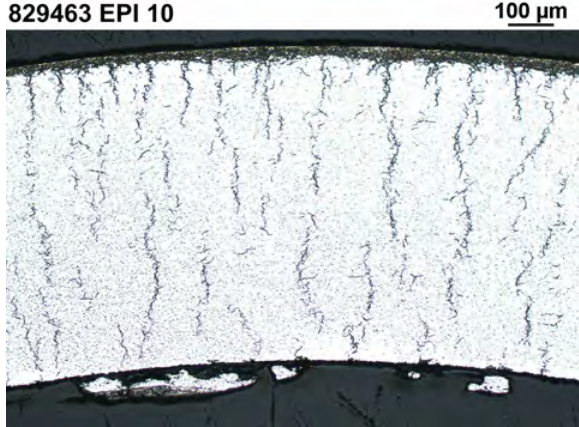
Figure 13. Sample 829 463. After hydrogen charging with inner pressure 9